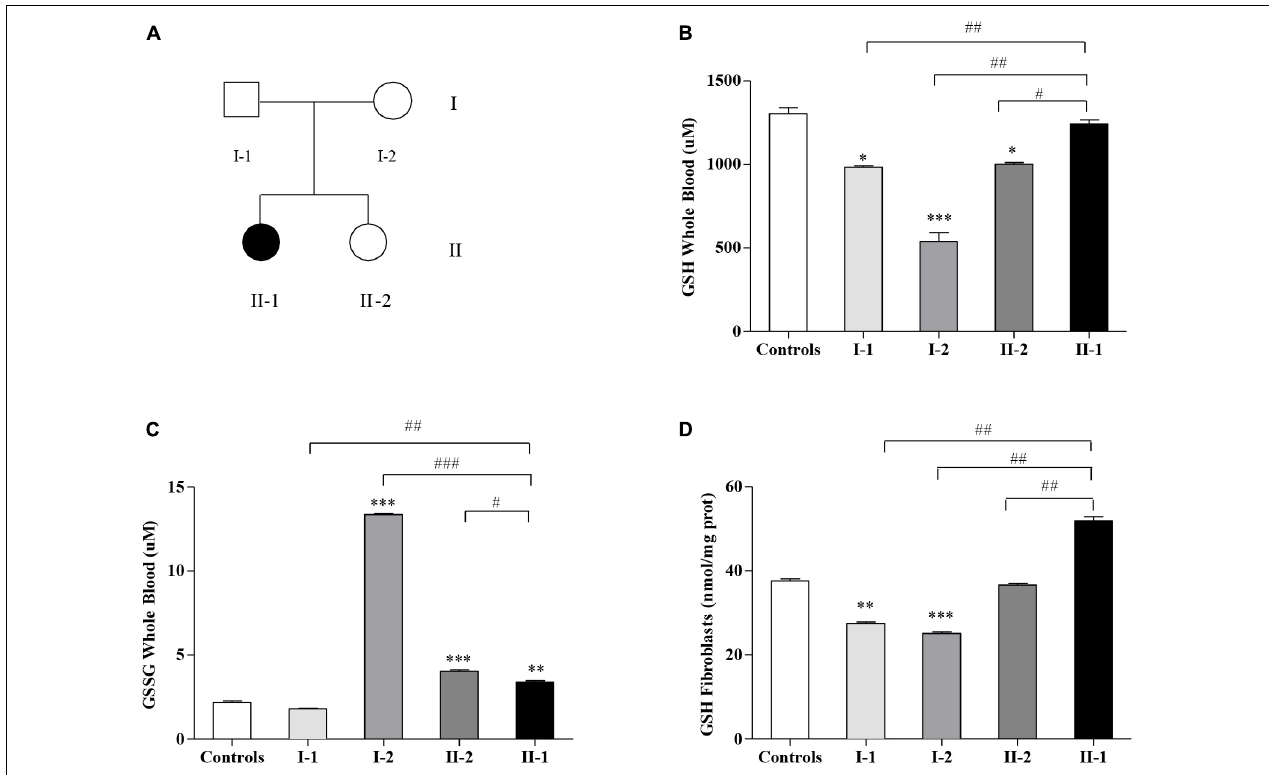
FIGURE 1 | Glutathione homeostasis in Friedreich’s ataxia (FRDA) family’s members. (A) Family tree: father (I-1), mother (I-2), younger sister (II-2), and affected proband (II-1) indicated by a black symbol. Reduced glutathione (GSH) (B) and oxidized GSSG (C) concentrations in the whole blood, and GSH content in fibroblasts (D) of I-1, I-2, II-2, and proband II-1 as measured by the enzymatic re-cycling assay. Values are expressed as median ± SEM. Statistical significance was defined as * p < 0.05, ** p < 0.01, and *** p < 0.001 with respect to the controls; and # p < 0.05, ## p < 0.01, and ### p < 0.001 compared with proband